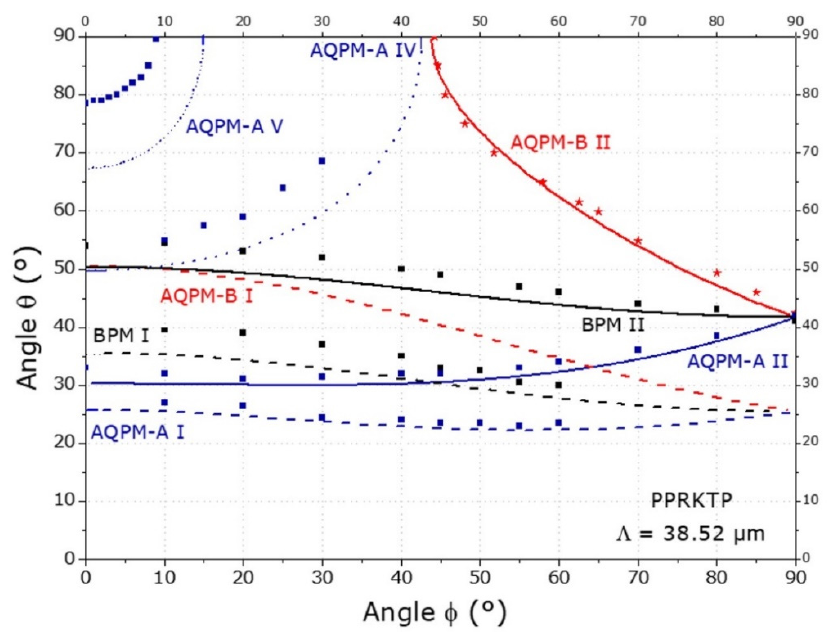
Figure 11. SHG at a fundamental wavelength λω = 2.15 µm in a spherical PPRKTP crystal with a grating period Λ = 38.52 µm: calculated Types I and II BPM angles (black lines), calculated Types I, II, IV and V AQPM-A angles (blue lines), Types I and II AQPM-B angles (red lines) and red stars for the measurements described in [21]). Black and blue squares are experimental data obtained in [20]. θ and 𝜙 are the angles of spherical coordinate in the dielectric frame (x, y, z).